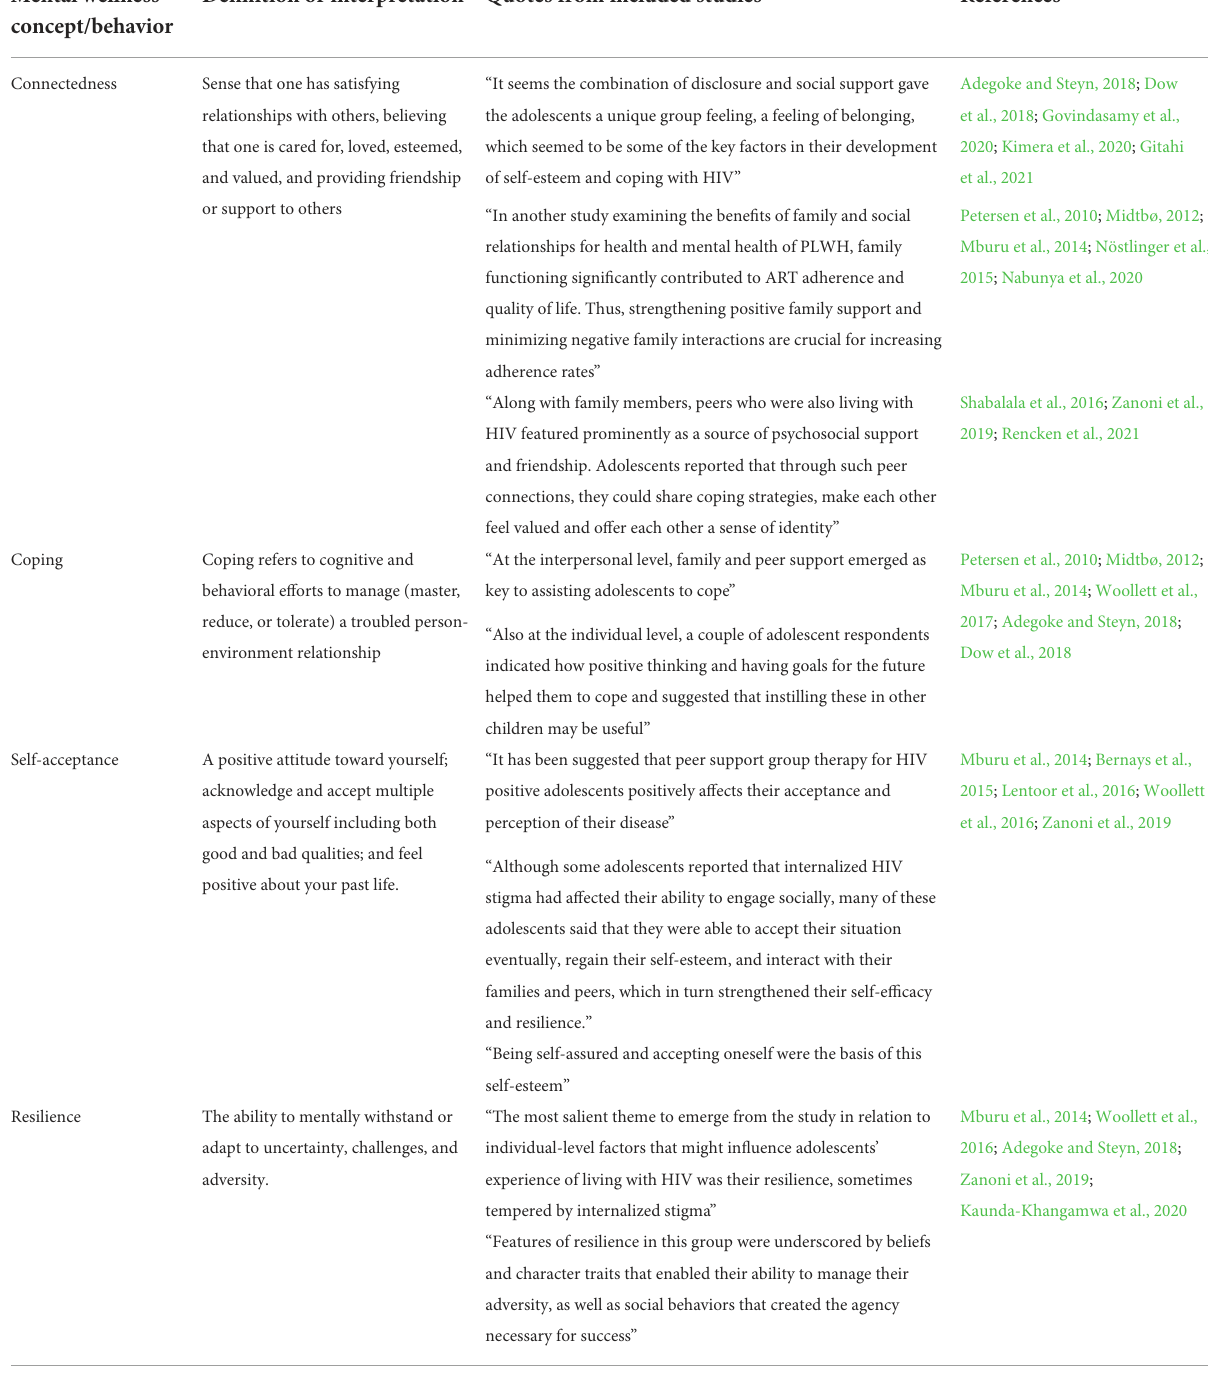
TABLE 2 Mental wellness concepts and behaviors from the